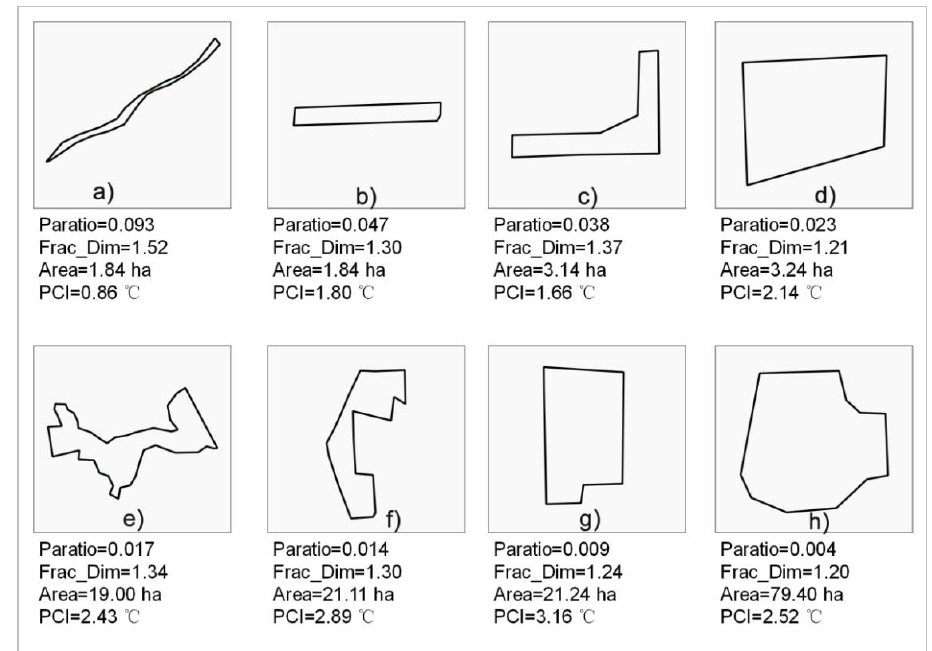
Figure 9. Comparison of PCI with different fractal dimensions (Frac_Dim) and perimeter area ratios (Paratio). Typical park shapes with higher Frac_Dim and Paratio values ( a , b , e , f ,) and typical shapes with lower Frac_Dim and Paratio values ( c , d , g , h ).